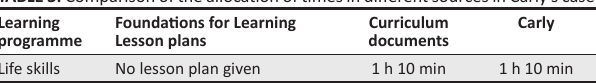
TABLE 3: Comparison of the allocation of times in different sources in Carly’s case.